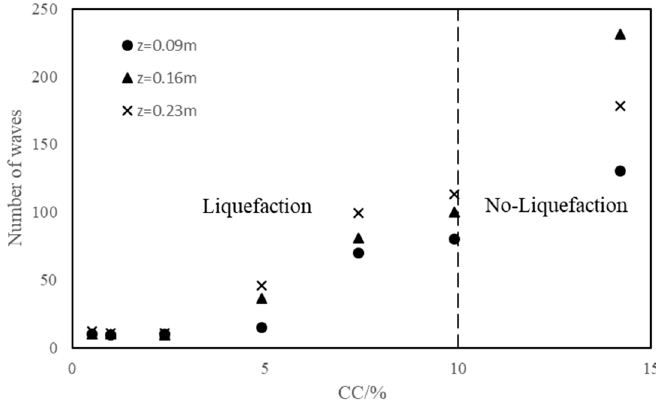
Figure 8. Number of waves (cycles) for period-averaged EPP to reach P ACC at different depth.